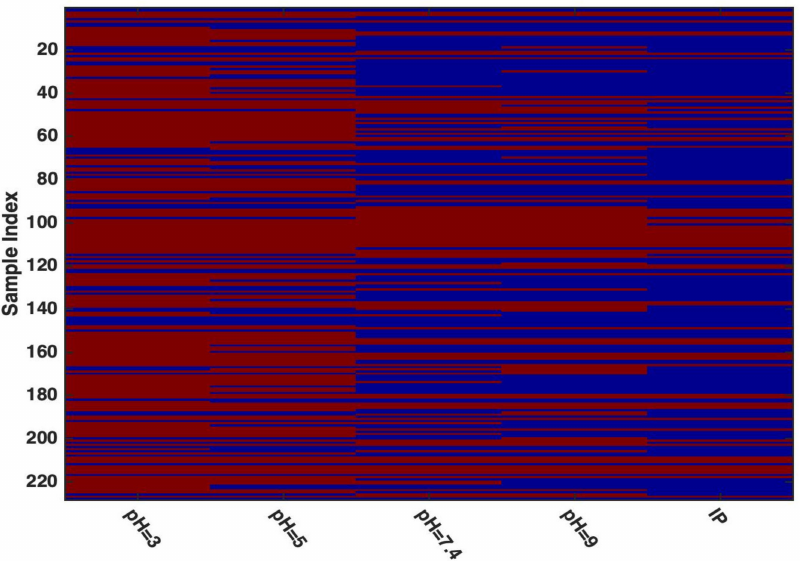
Figure 1. Distribution of the molecules into the two classes according to the different pHs, together with IP-based outcome. Legend: red—low permeability; blue—high